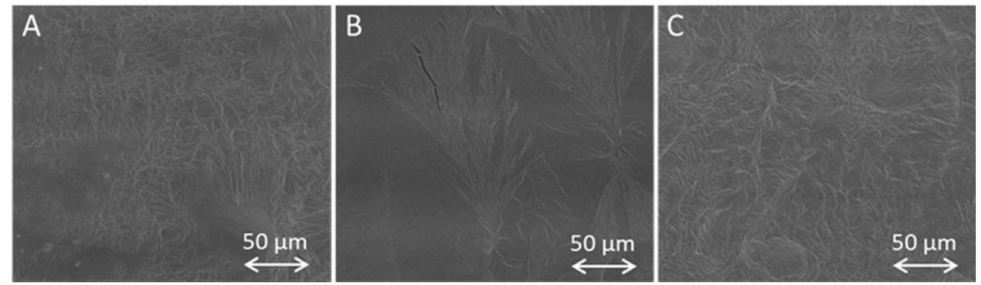
Figure 3. Comparison of representative SEM images for PEGDA samples (20 wt %) with different molecular masses of ( A ) 4000, ( B ) 10,000, or ( C ) 20,000 g/mol containing BSA–FITC.